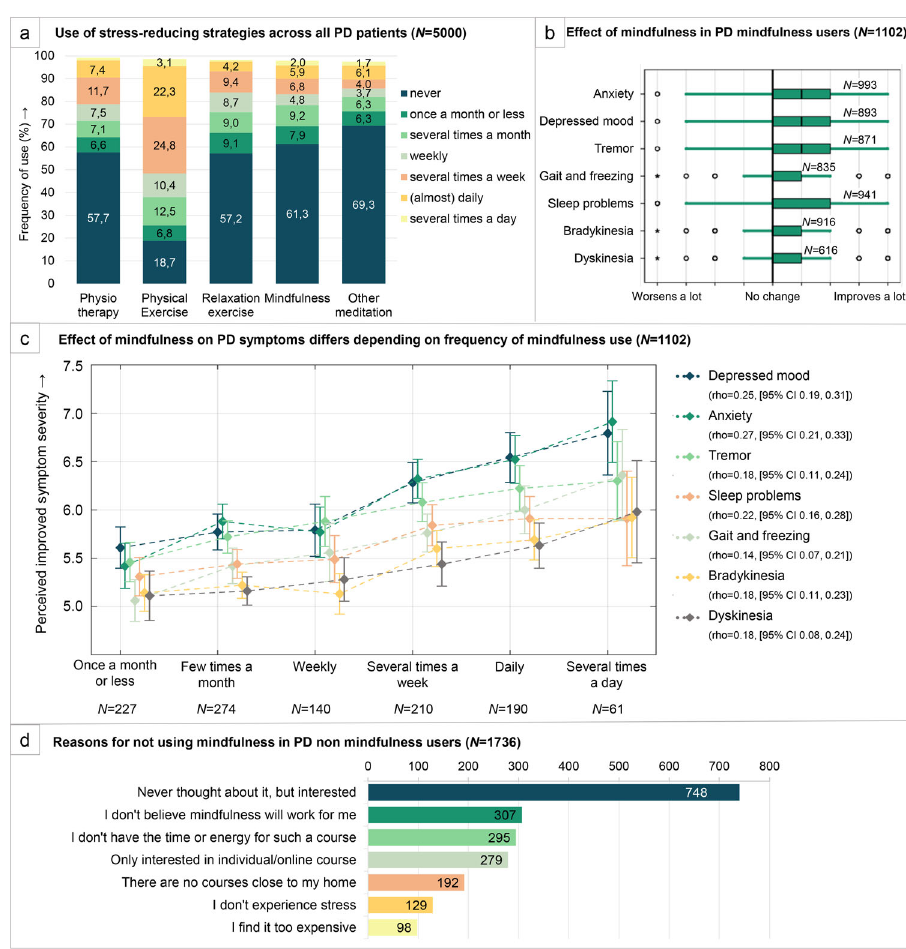
Fig. 3 Perceived effect of mindfulness to reduce stress in PD patients. a The frequency with which patients use prespeci fi ed ways to reduce stress level in percentage of responders. Physical exercise could be for example walking, cycling, swimming, or sports; relaxation exercise entailed for example yoga, Pilates, or Tai Chi. b , c The change in PD symptoms that patients since they started practicing mindfulness (part of optional questions). Responses were given on a 9-point scale in which 1 stood for a lot more severity in this symptom, 5 stood for no change, and 9 for a lot of improvement. b Responses are visualized here in a boxplot, in which the box corresponds to 75% of responses and the tails are the remaining 25%, except outliers. Open circles show small outliers and stars show extreme outliers. Vertical lines are answer options on the 9-point scale. All shown effects are signi fi cantly different from “ no change ” , p < 0.0071 corrected. c The positive relationship between the frequency with which mindfulness was practiced, and the level of improvements of PD symptom severity that was experienced. Lines represent the mean improvement on every PD symptom per mindfulness practice frequency, including 95% CI of all responses. Spearman ’ s correlations (rho) with corresponding 95% CI for all symptoms are shown in the legend. d Reasons to not practice mindfulness. Patients were allowed multiple answer options (part of optional